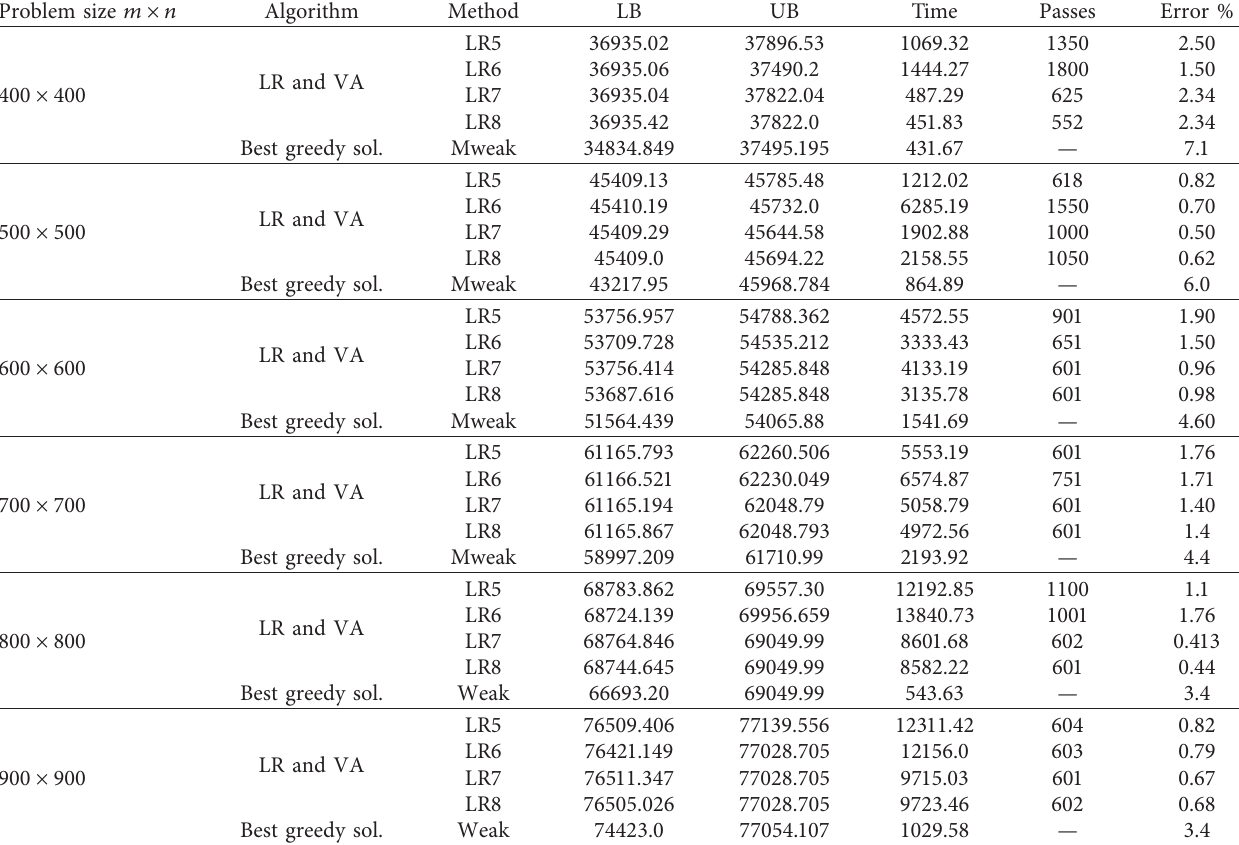
Table 2: Computational results of the LD and VA for the medium problems of size 400–900.